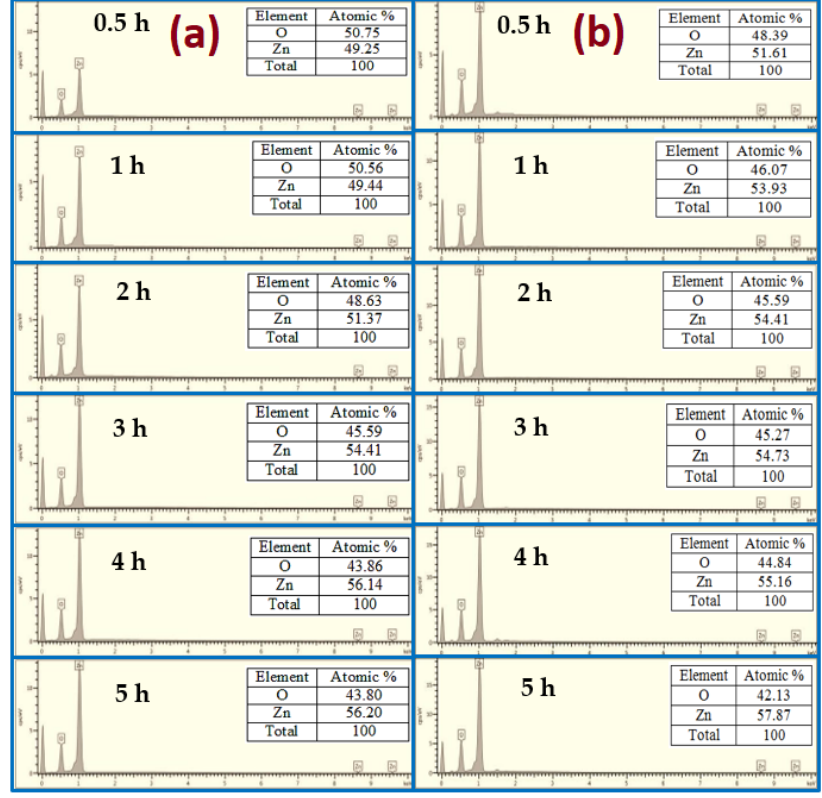
Figure 7. EDX analysis of ZnO NRs for different growth durations: ( a ) no air bubbles and ( b ) air bubbles.